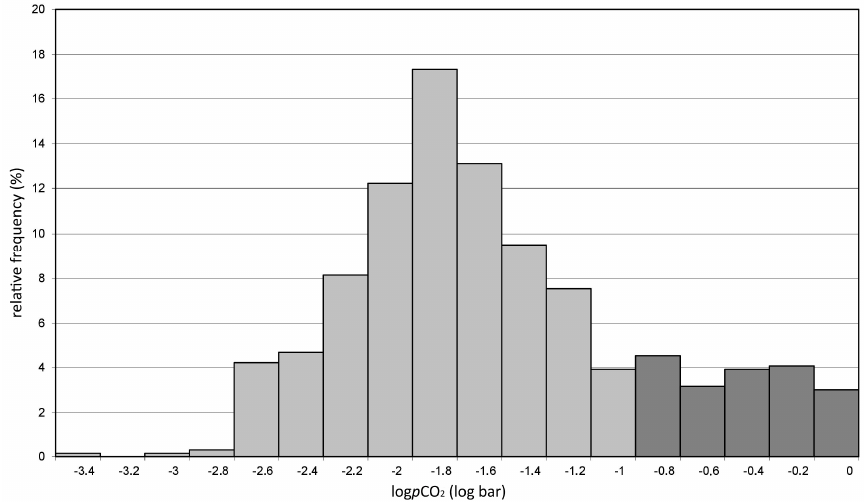
Figure 2. Histogram of log p CO 2 values of the collected